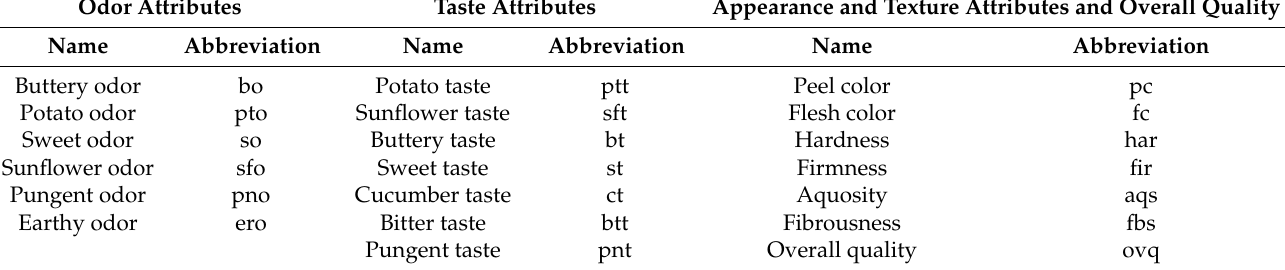
Table 1. Sensory attributes used in the quantitative descriptive analysis (QDA) of organic and conventional courgette fruits of Astra Polka and Nimba cultivar. Taste Attributes Appearance and Texture Attributes and Overall